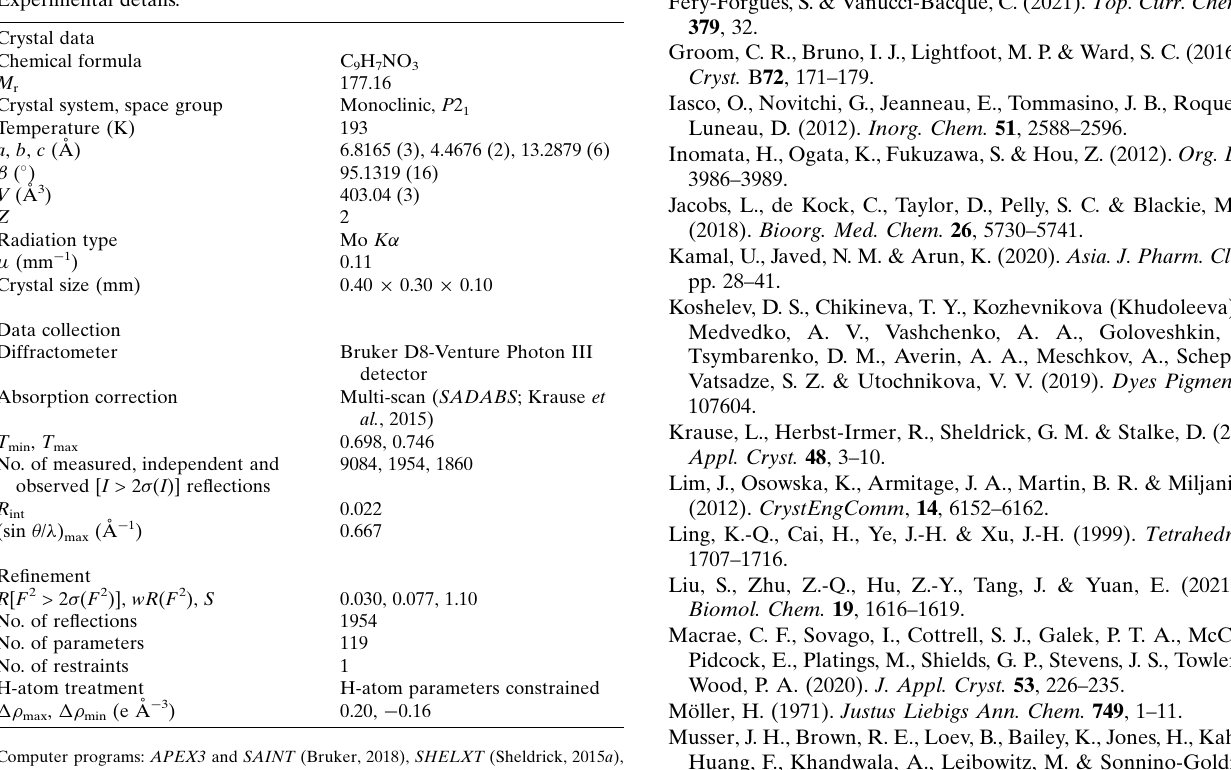
trically and treated as riding atoms with C—H = 0.95 A˚ (aromatic) or 0.98 A˚ (CH (CH ). 1.5 U eq 3